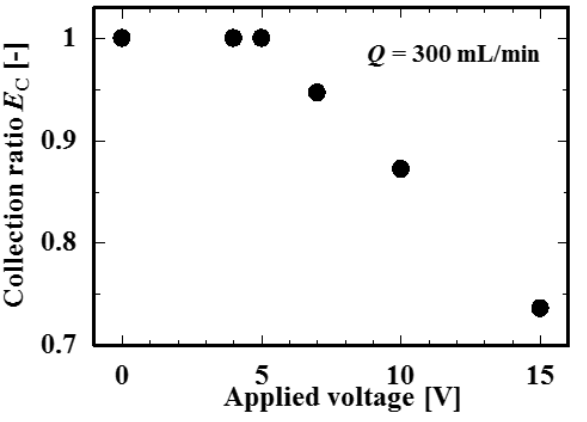
Fig. 6 Relationship between collection ratio and applied voltage at the total flow rate of 300